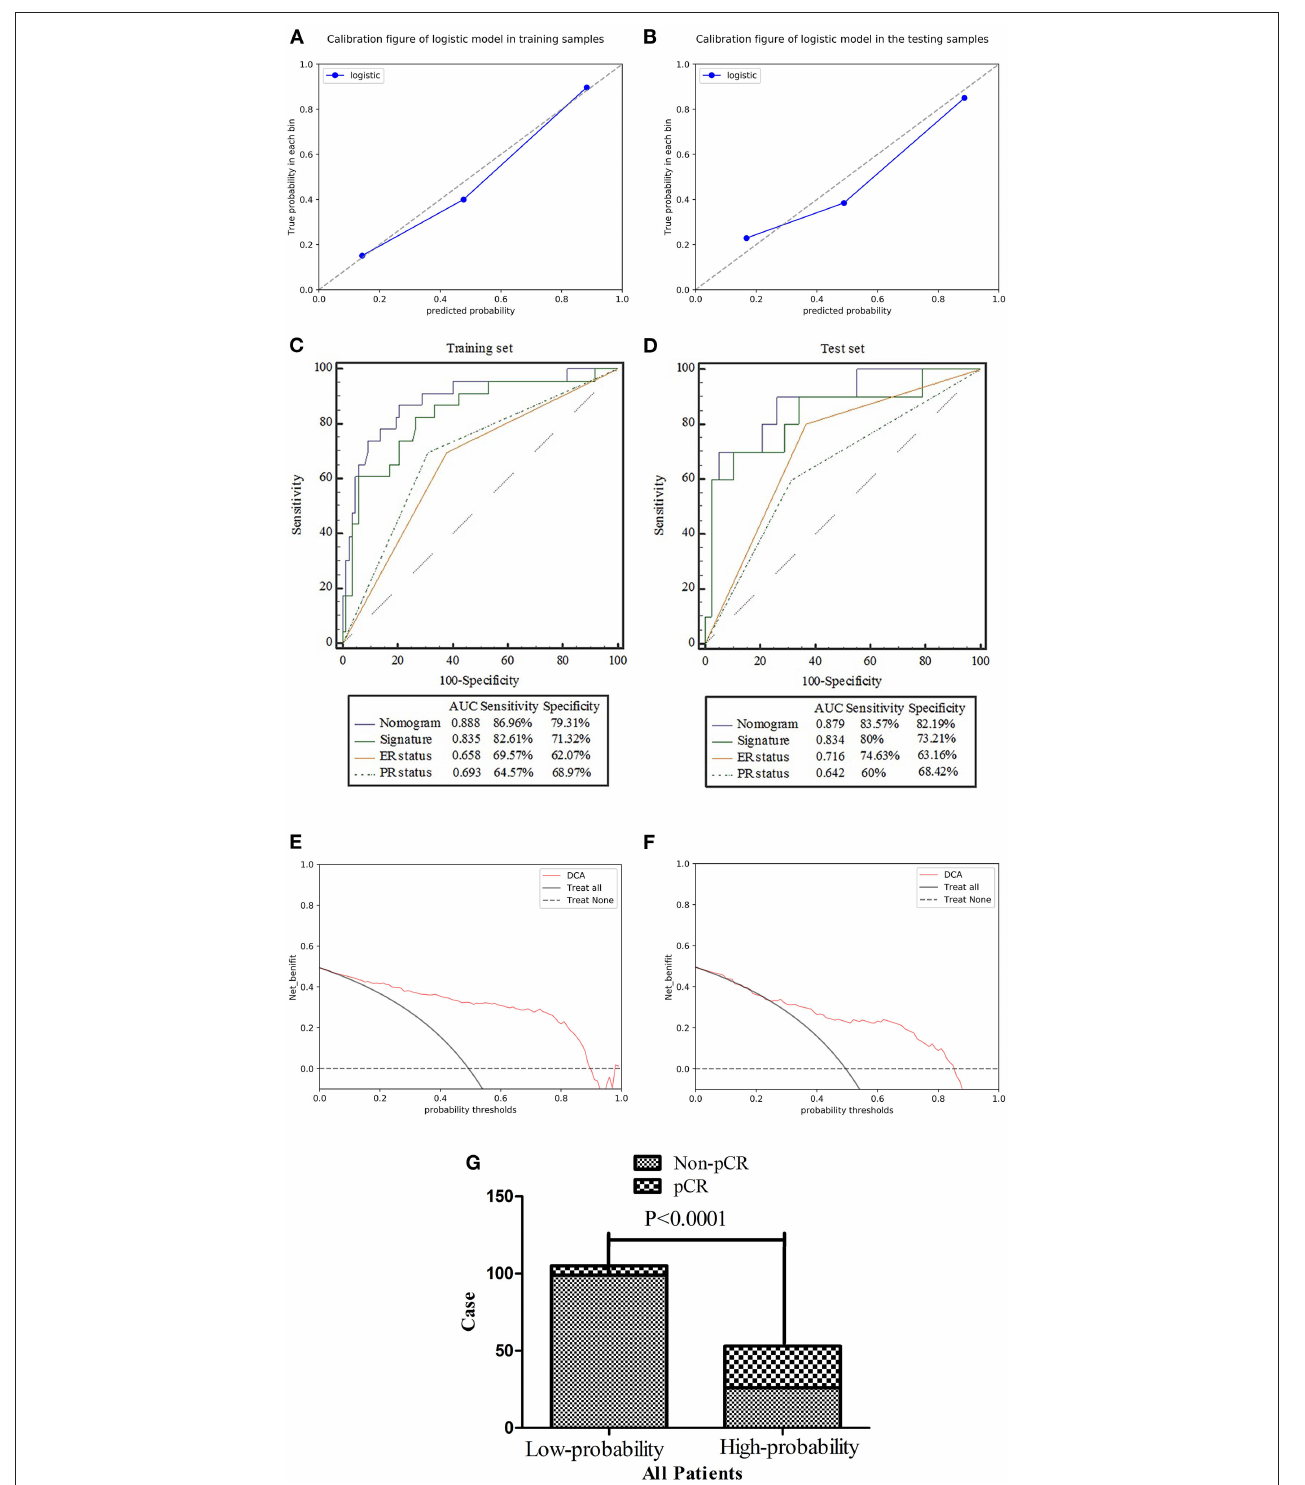
FIGURE 6 | (A,B) Calibration of the radiomics nomogram for predicting pCR in the training and test sets. Dashed line is the reference line where an ideal nomogram would lie, while the solid line corrects for any bias in the hybrid nomogram. (C,D) Evaluation of the accuracy of the ER status, PR status, radiomics signature, and nomogram for predicting pCR in the training and test sets. (E,F) Decision curve analysis was used to show the clinical effect of the nomogram in the prediction of pCR in breast cancer (BCa) patients in training and test sets. (G) Probability of pCR in the high-probability group was significantly higher than that in the low-probability group ( p <